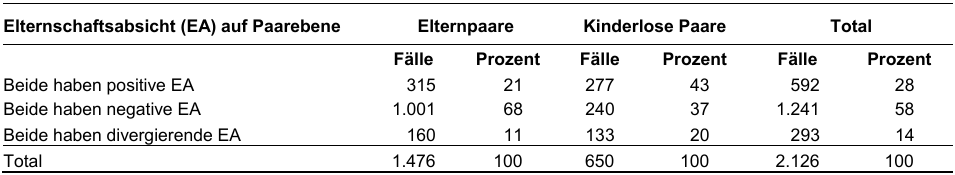
Tabelle 1 : Verteilung der Elternschaftsabsicht (EA) auf Paarebene nach